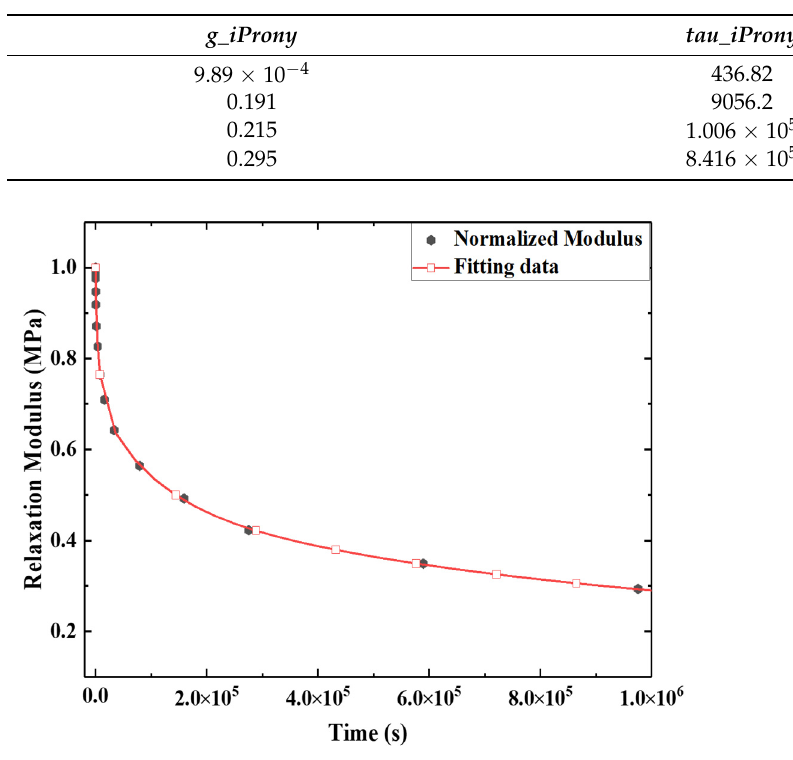
Figure 12. Fitting results for the master curve at 30 °C. Figure 13. Schematic diagram of the test piece.